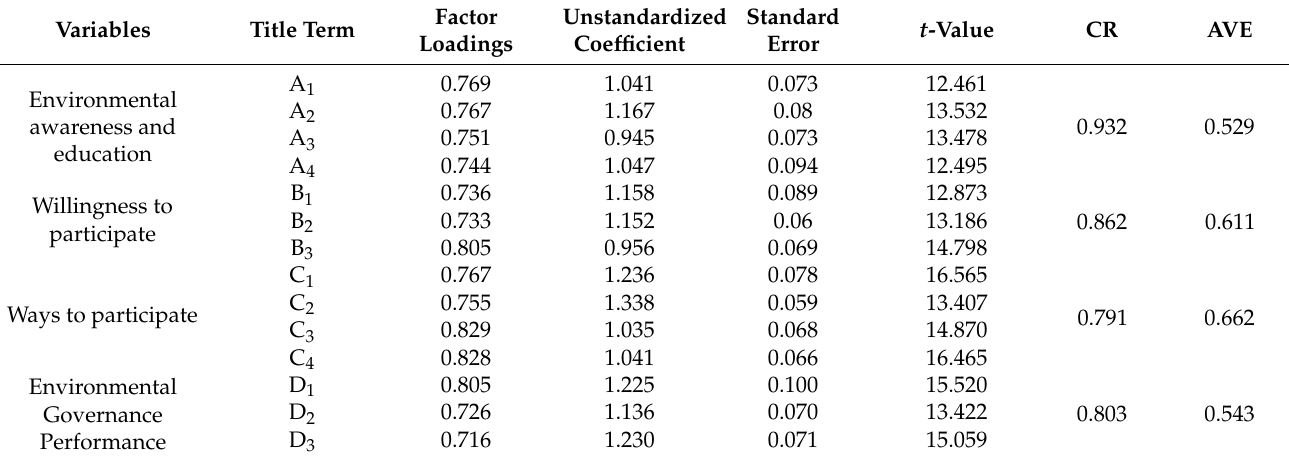
Table 3. Results of convergent validity test.